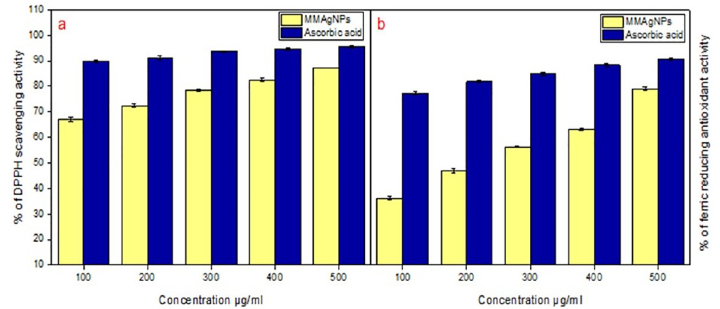
Fig 7. Antioxidant activity: (a) DPPH scavenging activity. (b) Ferric reducing antioxidant activity.